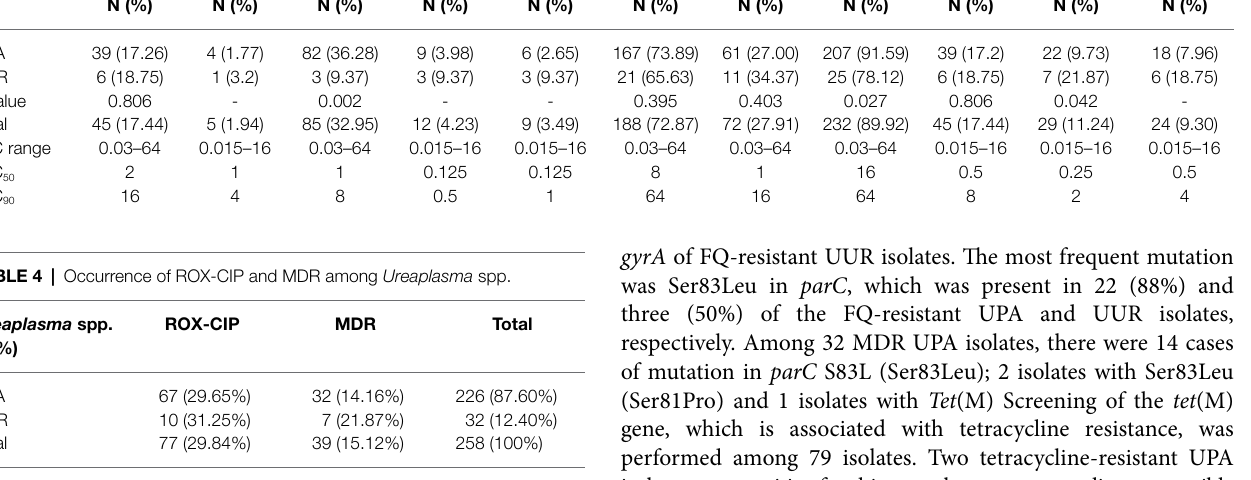
TABLE 3 | Antimicrobial in vitro resistance profiles of 258 clinical Ureaplasma spp. isolates. ERY